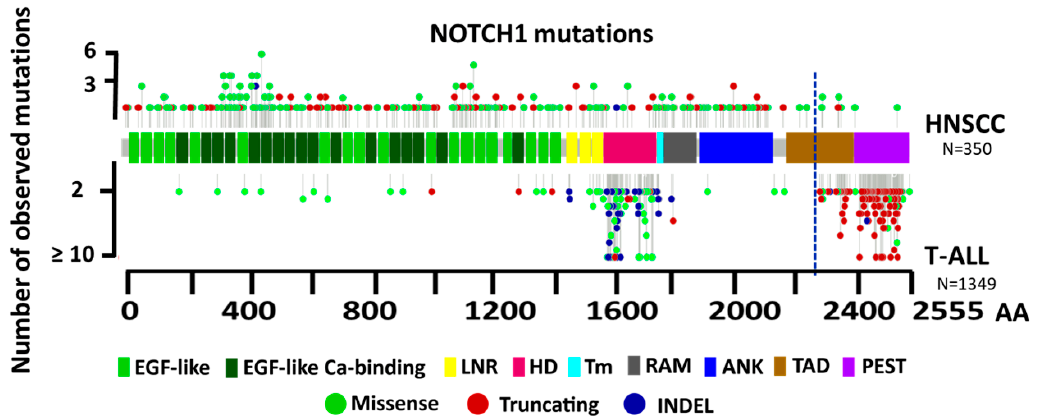
Figure 2. Schematic representation of NOTCH1 mutation distributions in HNSCC and T cell acute lymphoblastic leukemia (T-ALL). NOTCH1 mutations from unique patients reported from genomic studies in the COSMIC database and The Cancer Genome Atlas (TCGA) Pan-cancer cohorts were filtered to remove variants that were not predicted to be impactful by either Protein Variation Effect Analyzer (PROVEAN) or Sorting Intolerant From Tolerant (SIFT) scores. All indels and missense alterations predicted to be impactful plus truncating (i.e., frame shift or nonsense) mutations for HNSCC (n = 350) are illustrated on the top half of the plot and those from T-ALL (n = 1349) are on the bottom half of the diagram. A blue dotted line represents the approximate boundary separating the majority of truncating mutations in HNSCC from those found in T-ALL. AA, Amino acids; EGF, Epidermal growth factor; LNR, Negative regulatory region; HD, Hetero-dimerization domain; TM, Transmembrane domain; RAM, RBP-J κ -associated molecule; ANK, Ankyrin repeats; TAD, Transcription activation domain; PEST, C-terminal proline-, glutamate-, serine-, and threonine-rich sequence; INDEL, Insertion and